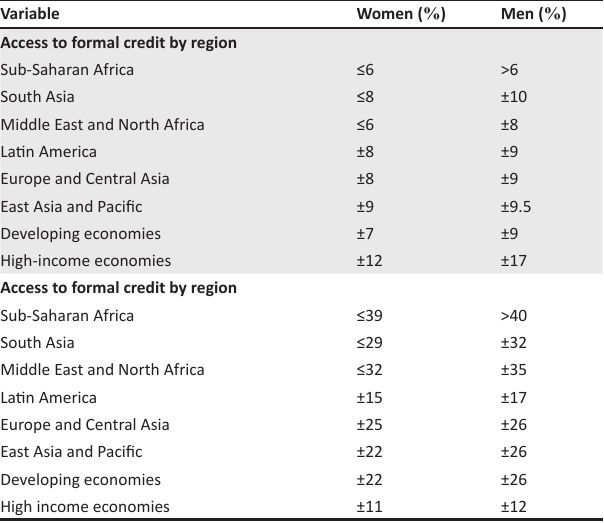
TABLE 3: Men and women’s access to formal and informal credit by region. Variable Women ( % ) Men ( %